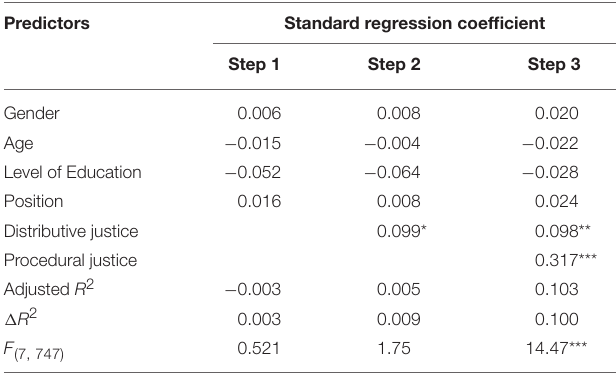
TABLE 5 | Hierarchical regression analyses ( N = 747).